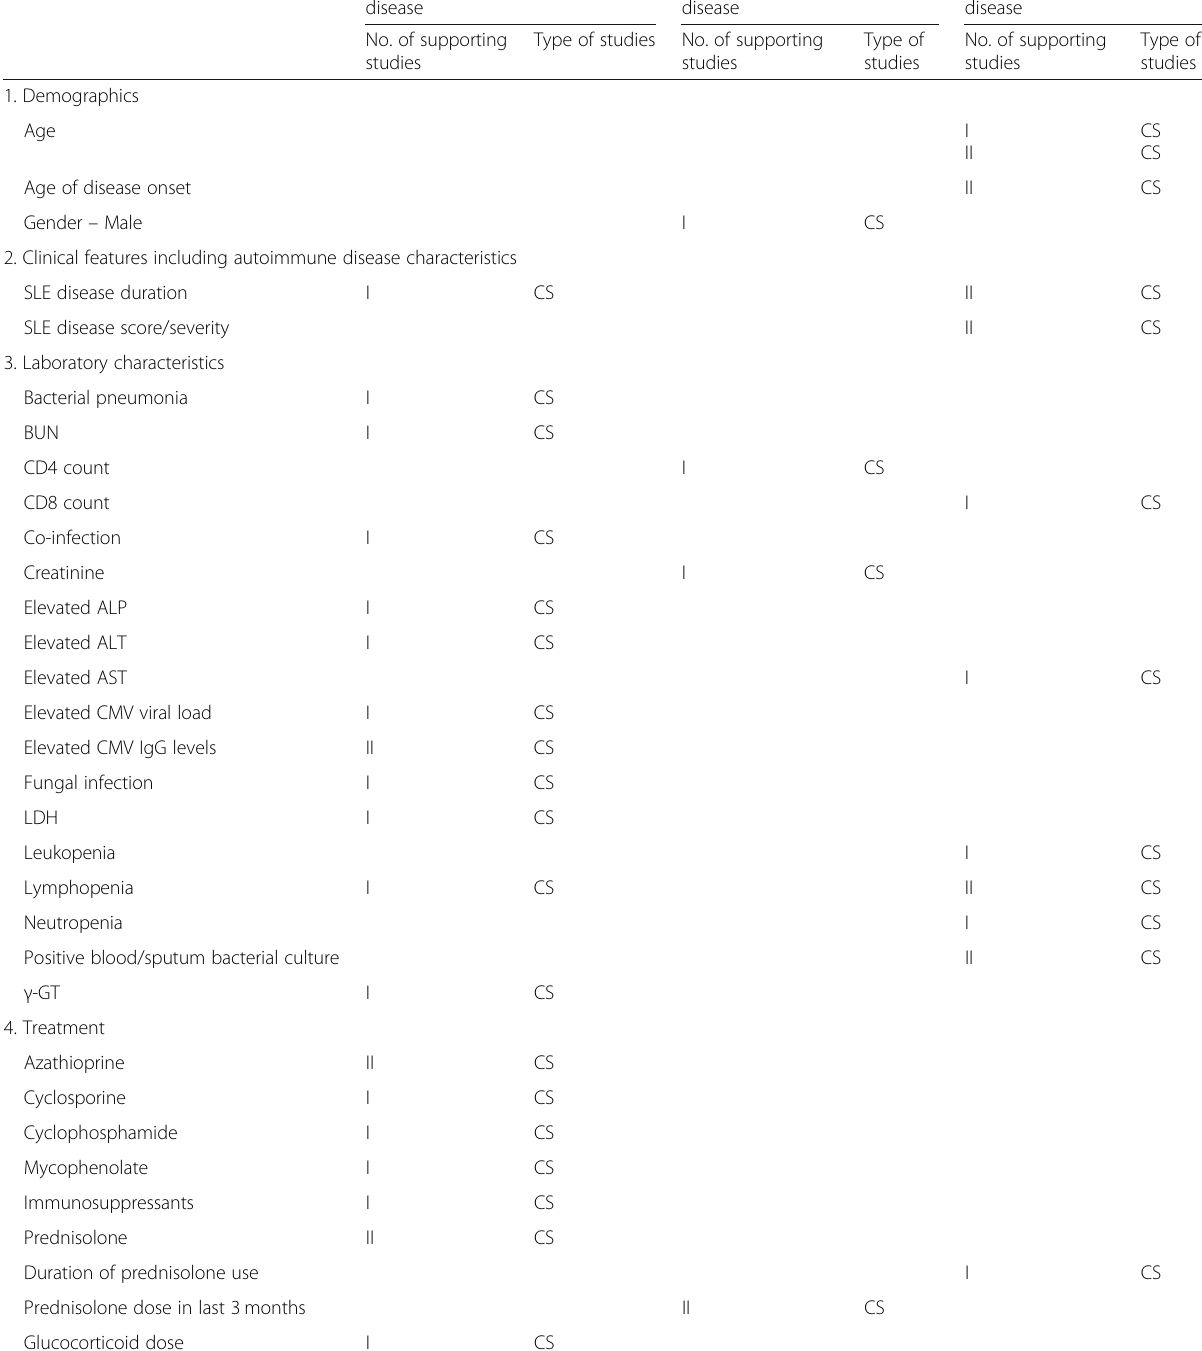
Negative correlation with CMV Neutral correlation with CMV disease